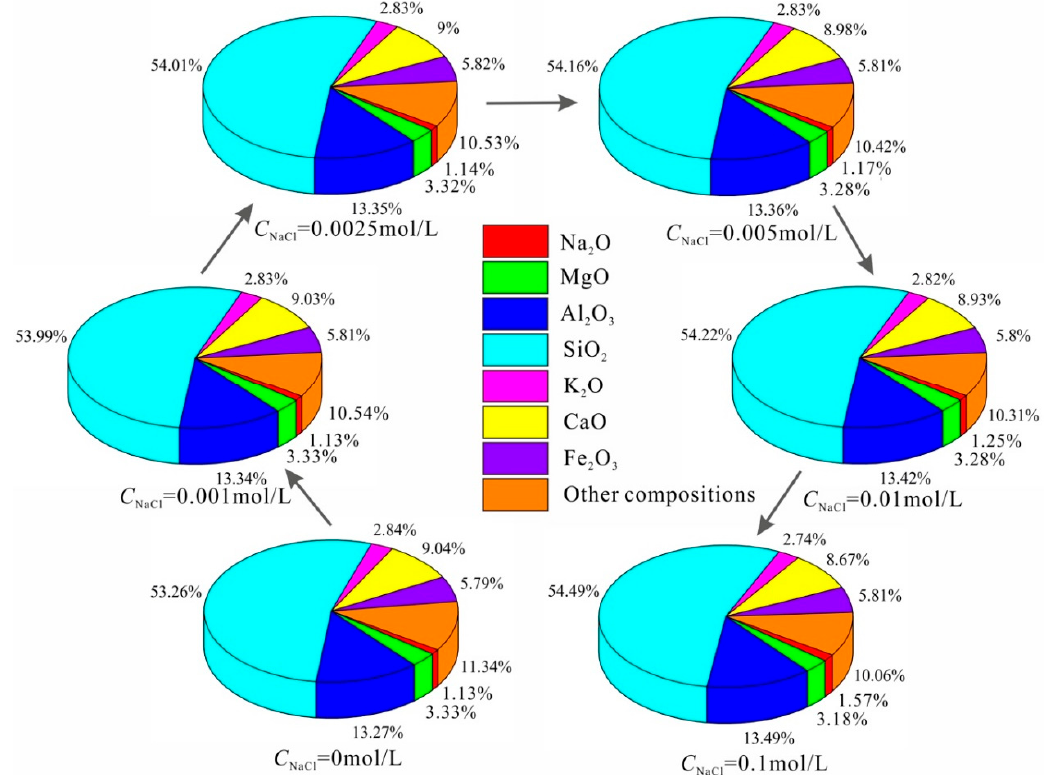
Figure 7. Chemical compositions of the loess samples after permeation.